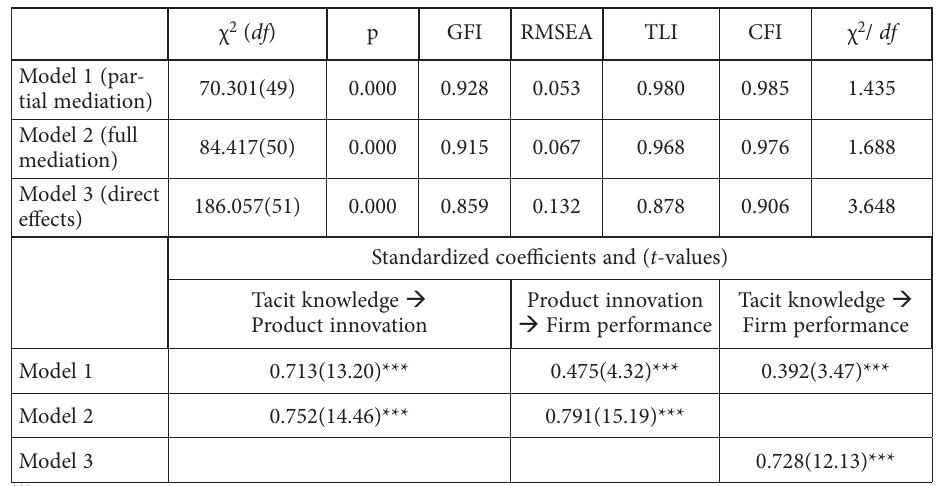
Table 3. Fit results and path coefficients for structural equation